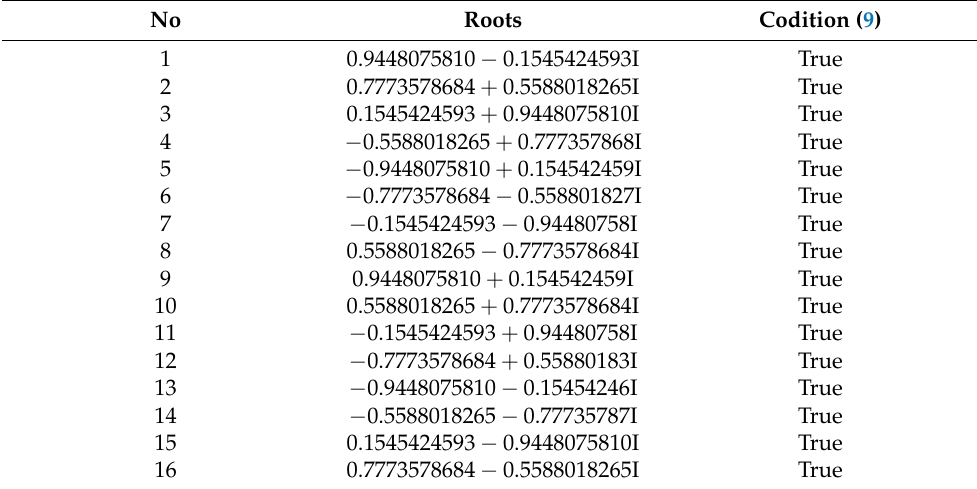
Table 1. Roots of the characteristic equation and their verification for condition